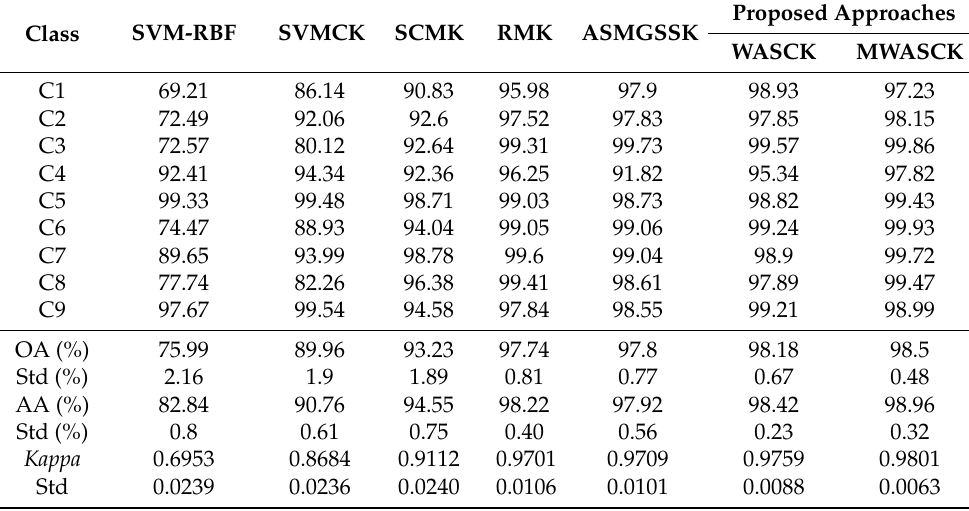
Table 3. Classification accuracy for the University of Pavia dataset.